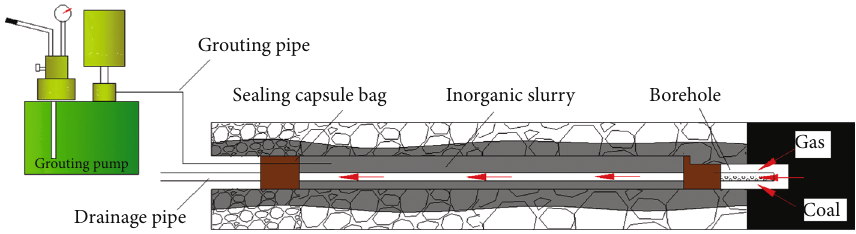
Figure 2: Schematic diagram of the constant pressure grouting with the inorganic